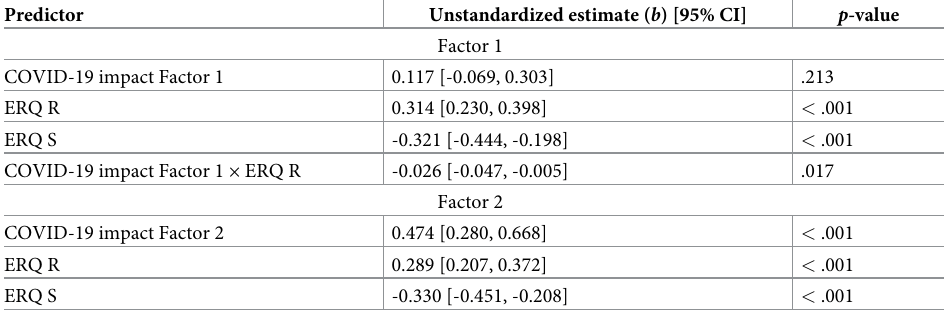
Table 4. Results of regression models predicting satisfaction with life from self-reported COVID-19 impact and emotion regulation